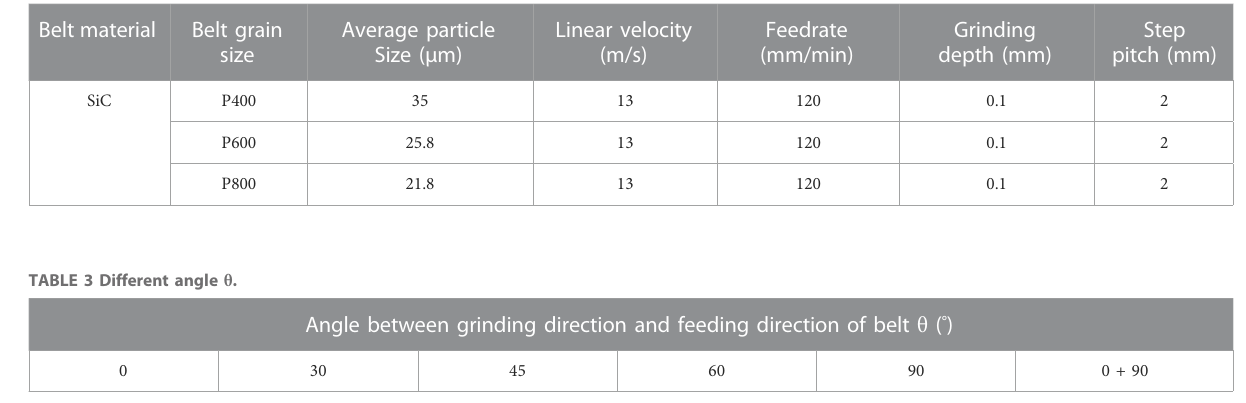
parameters were used for all three groups of experiments in order Table 2. To investigate the interaction between the abrasive belt grit and the surface material of a titanium alloy hollow blade during the grinding process. This test proposes a trajectory planning method in which the belt grinding direction is at an angle θ to the feed